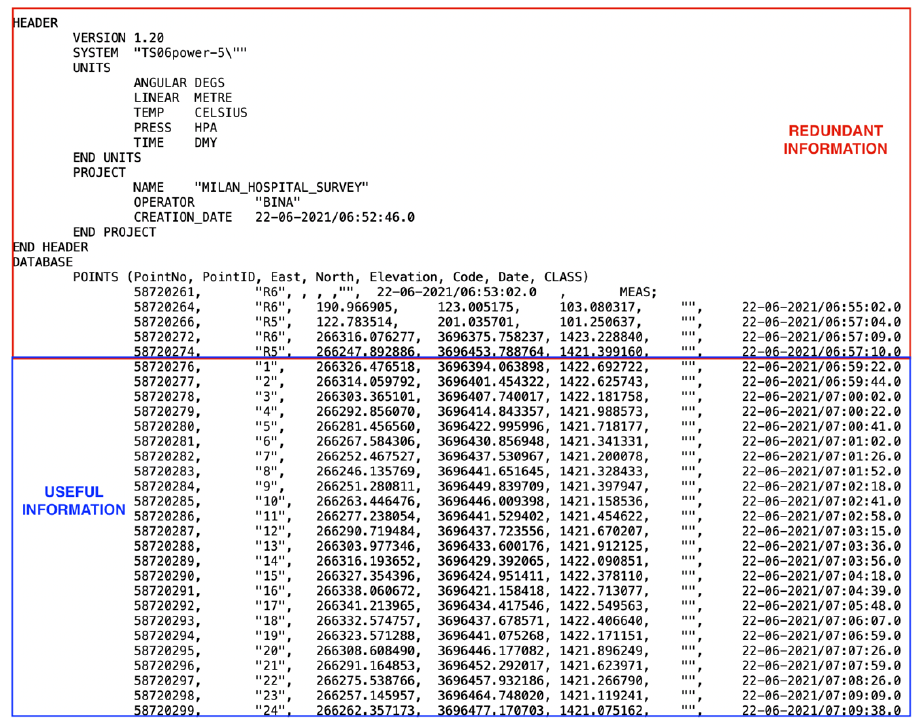
Figure 4. Pre-processing and data extraction from the acquired information. Having the data cleaned, in the next steps these data can be integrated with the virtual model to update the model and mirror the latest status of the physical entity, i.e., the soil deposit/borrow status. The virtual model was created and updated using Autodesk Revit 2020 authoring software that was connected live to the CDE in order to constantly retrieve data and update the virtual model and share it with the relevant stakeholders. Figure 5 demonstrates the virtual model that later can be used for different